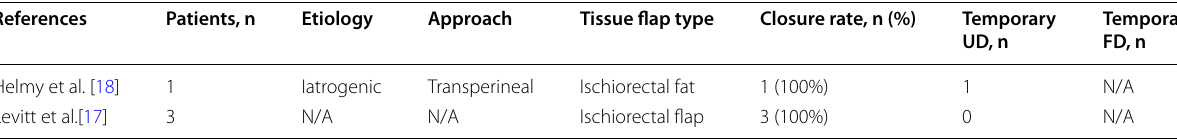
Table 1 Reported cases using local gluteal tissue flap for